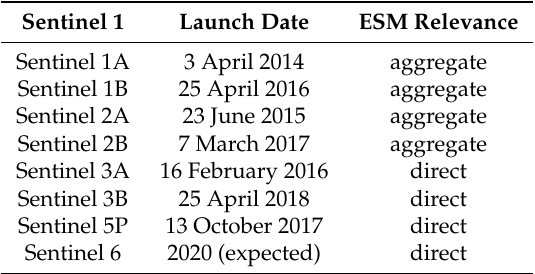
Figure 1. Copernicus Sentinels 1 to 6 (left to right). Table 1. Copernicus Sentinels launch dates and relevance in modelling application (aggregate use refers to composites in space and time, while direct use refers to single